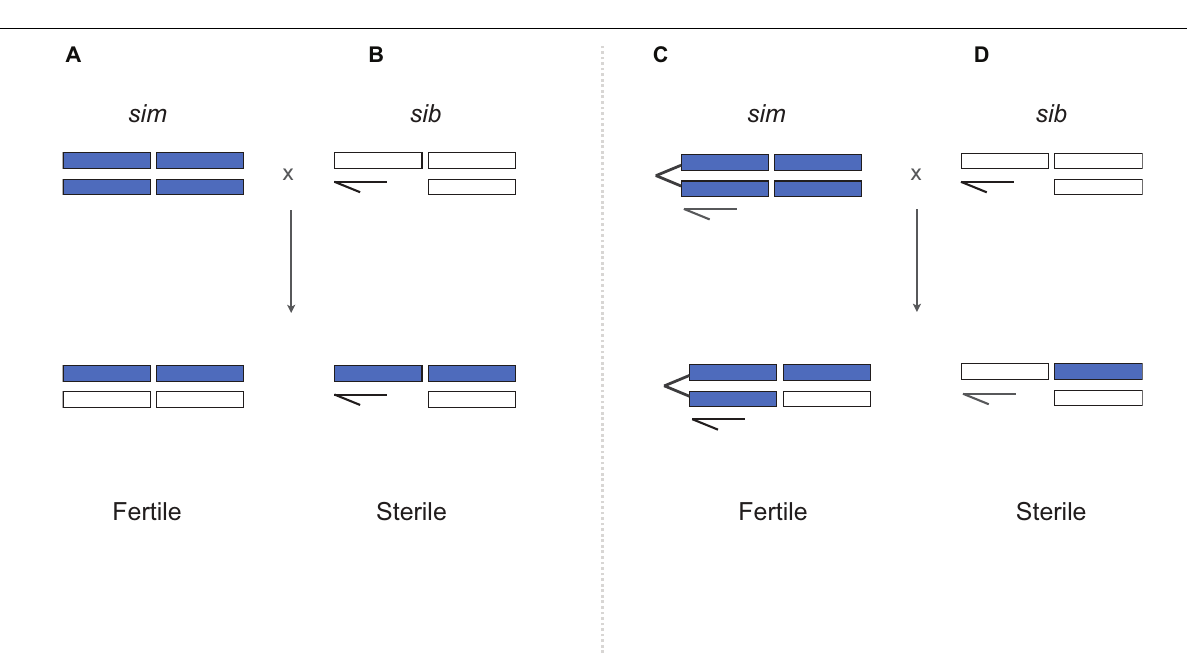
Frontiers in Genetics |